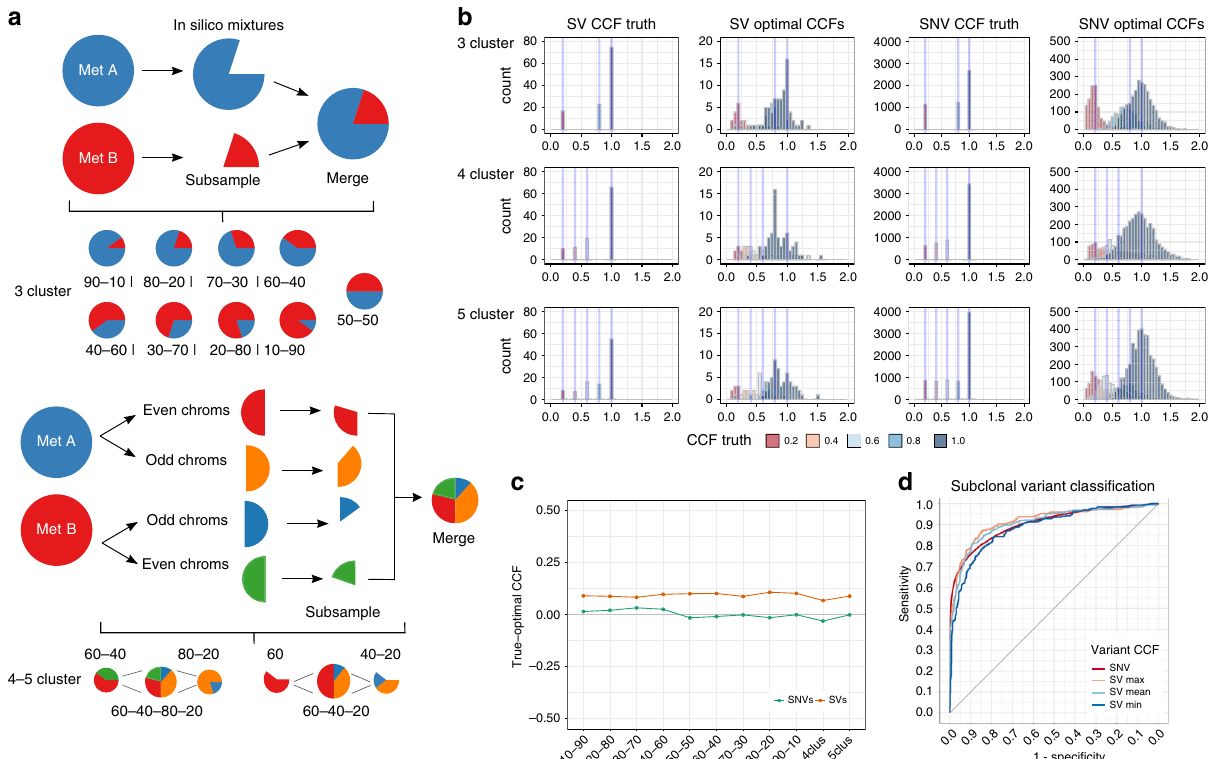
Fig. 2 In silico mixing strategy and optimal CCF calculation metrics. a A schematic illustrating the subsampling and merging process used to create in silico mixtures of real tumour samples. The top diagram shows the three-cluster in silico mixtures, created by mixing the two metastasis samples in different proportions. The bottom diagram shows the methodology for creating the four- and fi ve-cluster mixtures, which separates each mixture sample into even and odd chromosomes, then subsamples these samples to create additional clusters. The resultant CCFs are based on the subsampling percentage of each odd or even chromosome sample, rather than the sample proportion (as in the three-cluster mixtures). b The CCF ground truth (based on sample membership) versus optimal SV and SNV results (based on transformed variant allele frequencies from the true cluster mean) for a representative three-cluster mixture and the four- and fi ve-cluster mixtures. c Mean per-variant CCF error of optimal SNV and SV CCFs compared with the expected, ground truth CCF. d ROC curves for classifying variants as clonal or subclonal based on optimal variant four- and fi ve-cluster mixtures, demonstrating SVclone ’ s advan- tage in being able to consider >2 subclones. SVclone ’ s SNV clustering and PyClone displayed similar mean error trends